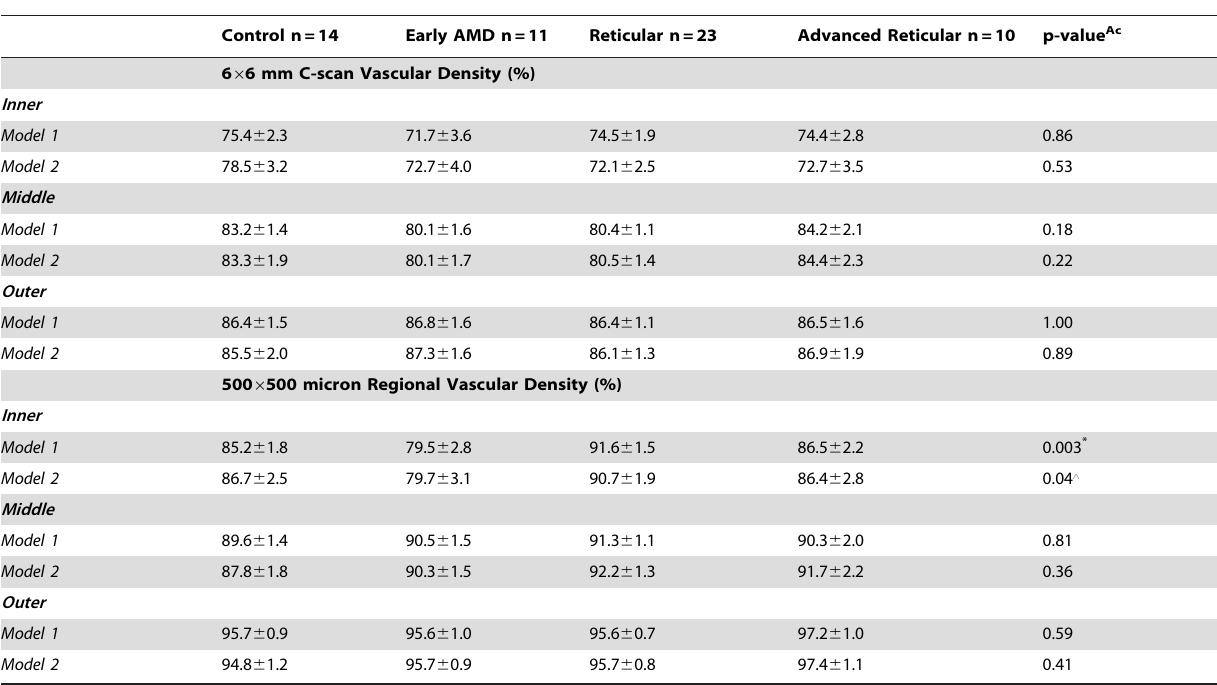
Table 2. Choroidal Vascular Density on C-Scans: Macular (6 6 6 mm) versus Regional (500 6 500 microns).